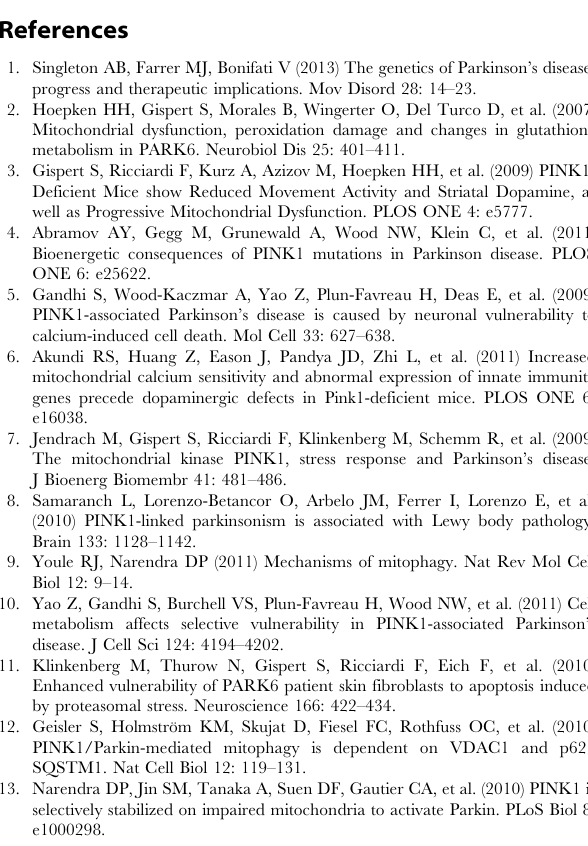
morphology was depicted by CLSM. Irradiation resulted in mitochondrial fragmentation but no changes induced by PINK1 knockdown are apparent; bar = 7 m m. Figure S6 , Degradation of fragmented mitochondria . In order to demonstrate lysosomal degrada- tion of fragmented mitochondria SH-SY5Y nt cells stained with MTR (panel on the left) were co-stained for LAMP-2 (panel in the middle). The merged image (panel on the right) shows clear co- localization of the MTR and the LAMP-2 staining (arrowheads); bar = 3 m m. Figure S7 , Establishment of an irradiation regime for SH- SY5Y cells . SH-SY5Y cells were stained with the photo-reactive dye MTR and irradiated for 30 or 45 min. 8 h after irradiation the mitochondrial morphology was determined by microscopy. about half of the cell population; n= 1, at least 100 cells/condition in at least 10 fields of view. Figure S8 , PINK1 overexpression increases acid phosphatase activity . HeLa cells were transiently transfected with PINK1-GFP or GFP and the acid phosphatase activity as parameter for lysosomal activity of 200.000 cells was